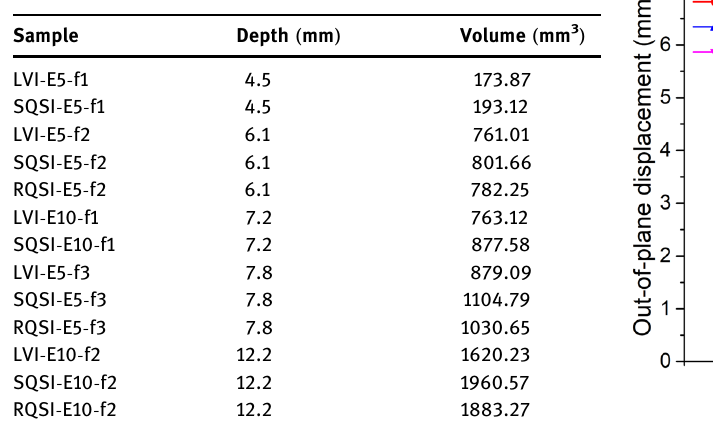
Table 3: Depth and volume obtained by DIC